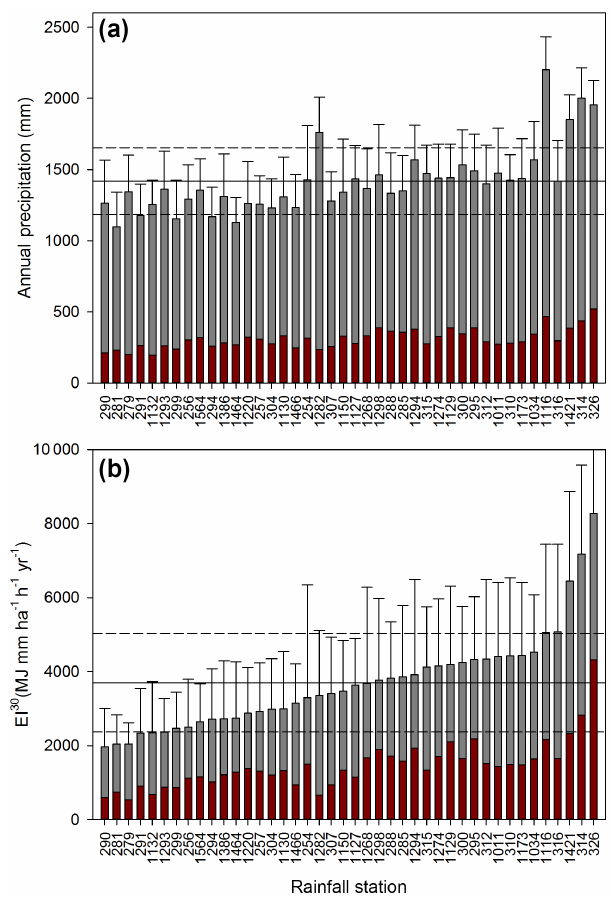
Figure 2. Total (grey) and typhoon-related (red) mean annual pre- cipitation (a) and R factor (b) with the solid line representing the mean and the dashed lines being 1 standard deviation from the mean. The error bars indicate 1 standard deviation from the mean for individual